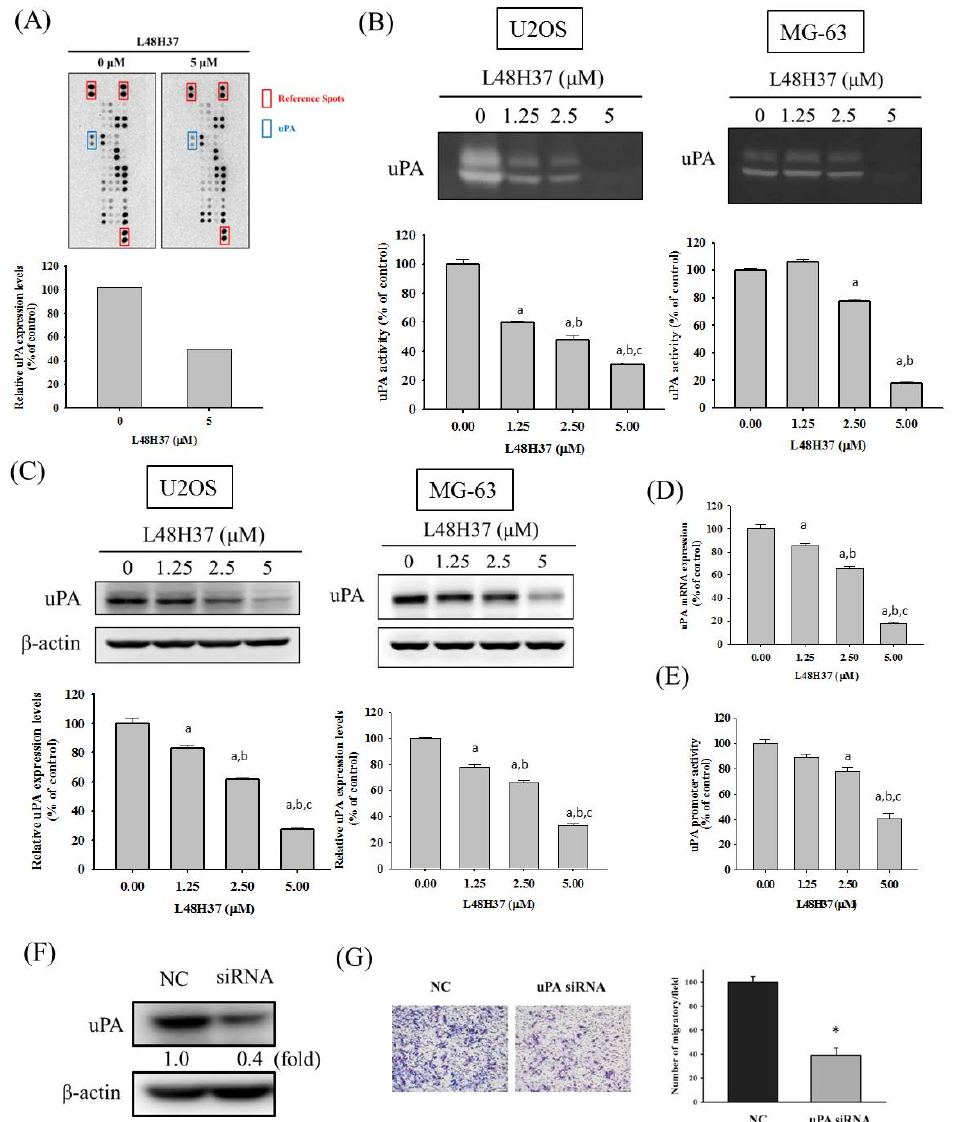
Figure 3. Expression of uPA in L48H37-treated U2OS cells. ( A ) The protease array, after treatment with 5 µ M of L48H37 for 24 h in U2OS cells, was employed, as described in the Materials and Methods section, and illustrated after quantitative analysis. ( B ) Casein zymography, ( C ) Western blotting analysis, ( D ) real-time PCR, and ( E ) luciferase reporter assay, after treatment with L48H37 at various concentrations (0, 1.25, 2.5, and 5 µ M) for 24 h in U2OS cells were conducted as described in the Materials and Methods section. Results are shown as mean ± SD. n = 3. ANOVA with Tukey’s post-hoc test was used. a Significantly different, p < 0.05, compared with control. b Significantly different, p < 0.05, compared with 1.25 μ M. c Significantly different, p < 0.05, compared with 2.5 μ M. ( F ) Western blotting assay to confirm siRNA directly against uPA expression and ( G ) Boyden chamber assay after treatment of uPA siRNA for 24 h in U2OS cells were conducted, and the effects were illustrated after quantitative analysis. Student’s t -test was used. * Significantly different, p < 0.05 compared with the negative control (NC) group.